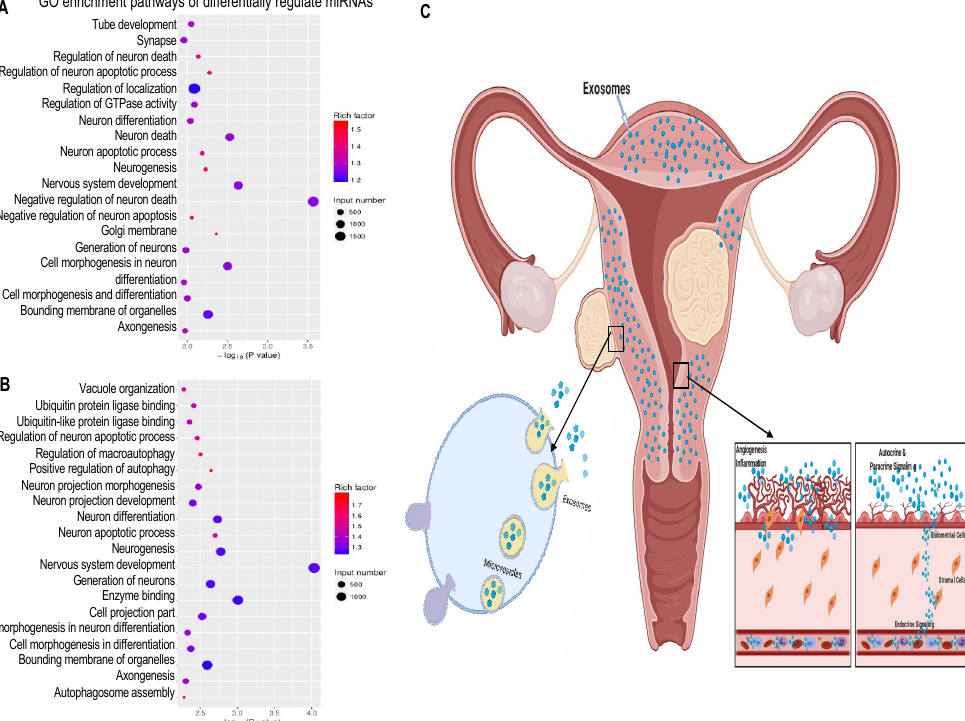
Figure 6. Pathway analysis of differentially regulated miRNA target genes and hypothetical model of human uterine leiomyoma-derived exosome. ( A , B ) GO enrichment analysis of differentially miRNA target genes demonstrated that both upregulated and downregulated target miRNAs were significantly enriched in binding membrane organelles, enzyme binding and nervous system development direction in HULM-EXO compared to UTSM-EXO. ( C ) Hypothetical model of human uterine leiomyoma-derived exosome’s action. After they are released, HULM-EXO (HULM-derived exosome) are taken up by neighboring and distant cells and cause abnormal function of the healthy endometrium. The presence of uterine leiomyomas cause alteration in the healthy endometrium and changes in exosome content, leading to increased factors involved in cell proliferation and angiogenesis, among others.